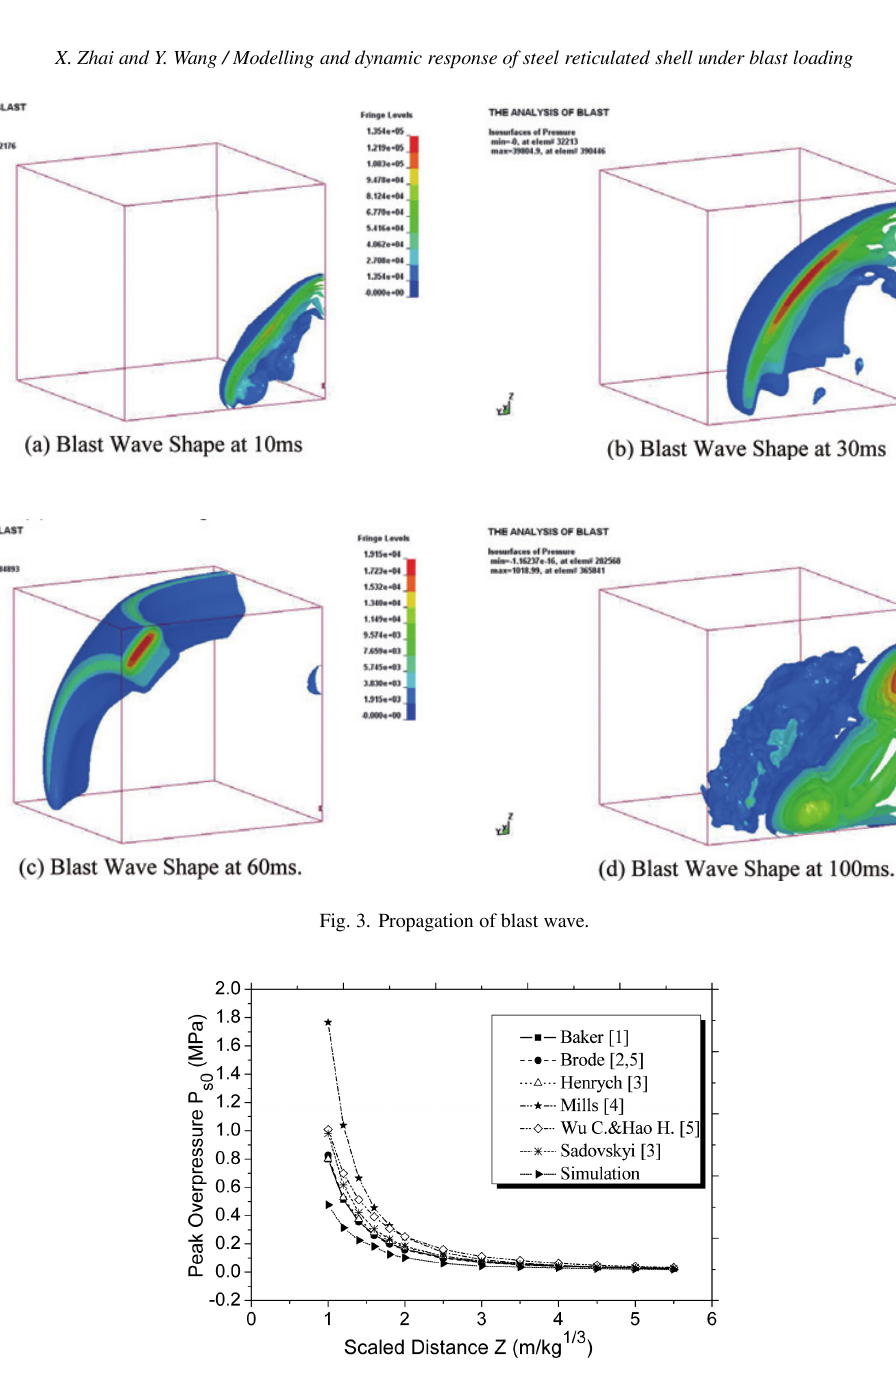
Fig. 4. Comparative curves between simulation peak overpressure and empirical